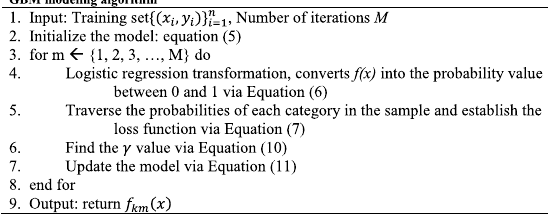
Algorithm 1. GBM modeling algorithm (Friedman,